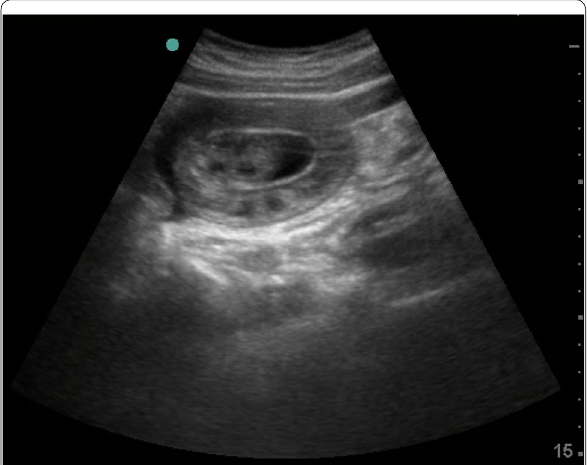
Fig. 1 Point of care ultrasound for acute abdomen (ACUTE approach) showed localized free fluid with doughnut sign edematous bowel loop wall